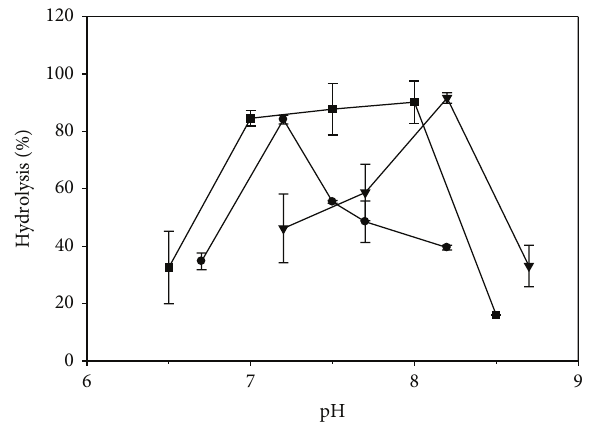
Figure5:EffectofpHonthehydrolysisofsaffloweroil,usinglipases from Candida rugosa type VII (CRL) ( e ), porcine pancreas type II (PPL) ( 󳶃 ), and Thermomyces lanuginosus (Lipozyme TL IM) ( ◼ ). Theoptimalbiocatalystamountwas1.3and2.0 mgsolidenzyme/mL reaction mixture for CRL and PPL, respectively, and 3.3 mg granular enzyme/mL reaction mixture for Lipozyme TL IM.